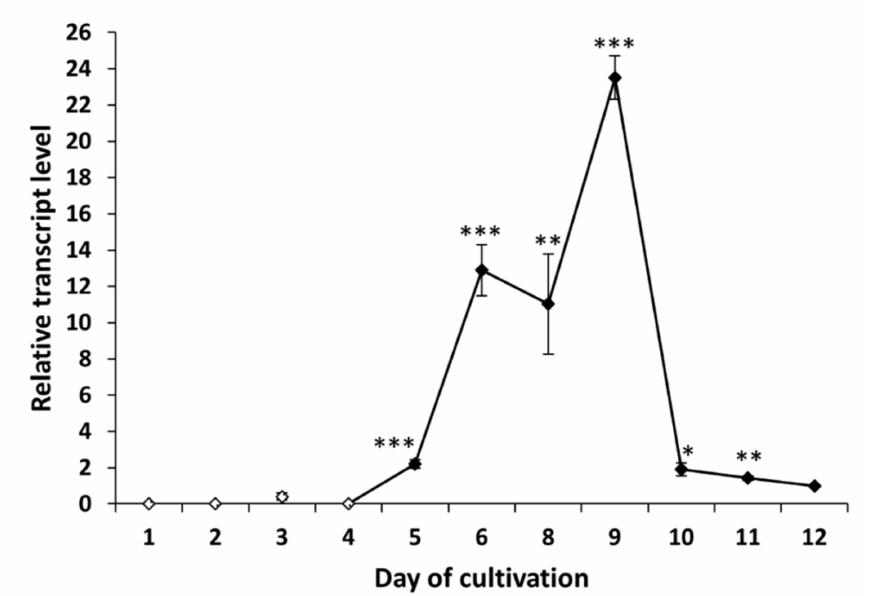
Figure 5. Expression profile of peptaibol synthetase tex1_Ta Trichoderma atroviride O1 cultivated in constant darkness (D). White points indicate undetected tex1_Ta transcript or, on the third day of cultivation, an insignificant amount of transcript. Reference (relative transcript level = 1) is the expression level detected on the 12th day of cultivation (12 d D). Values with p < 0.001, 0.001 < p < 0.01, and 0.01 < p < 0.05 (compared to reference) are marked with ***, ** and *,